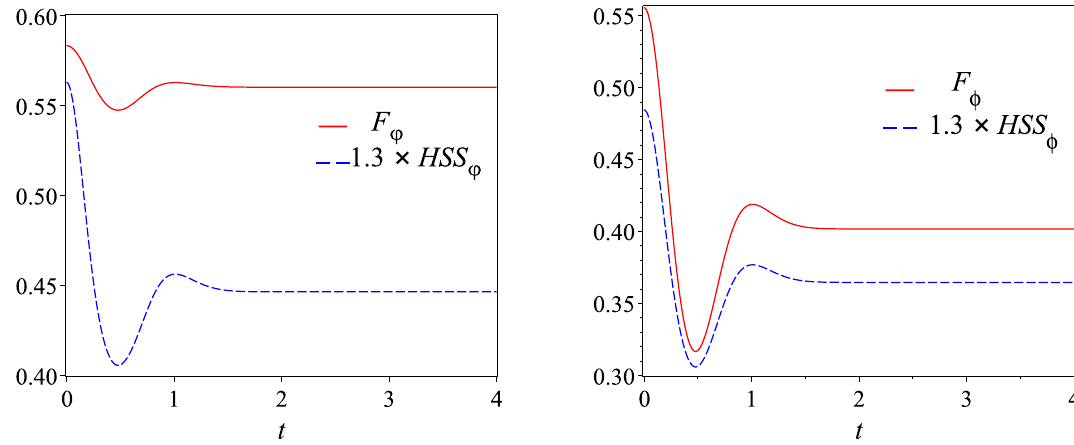
Figure 7. Dynamics of quantum Fisher information F ( t ) (red solid line) and Hilbert–Schmidt speed HSS ( t ) (amplified by 1.3 times for comparison, blue dashed line) which are computed with the same phase parameter as a function of time t for the ( a ) four-qubit system prepared in initial state (55) and ( b ) six-qubit system prepared in initial state (56) described in Fig. 6 when one of the qubits is affected by the